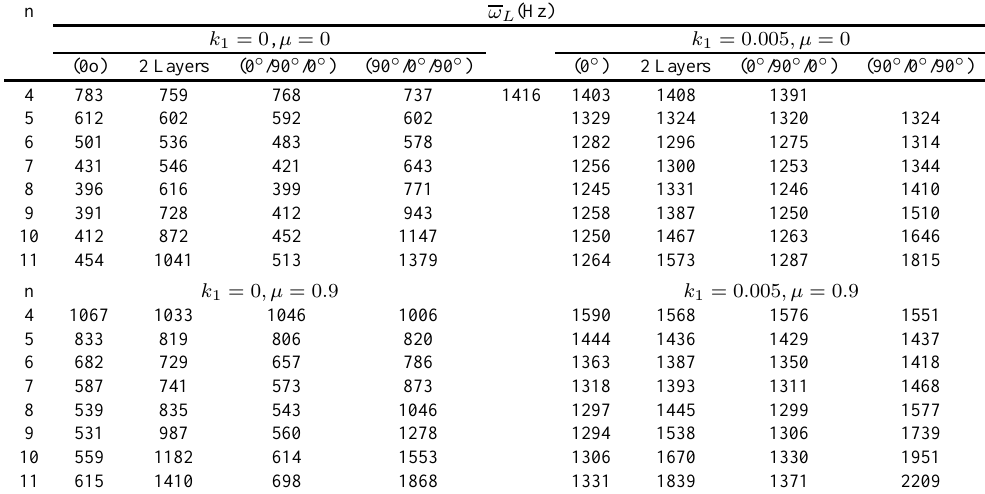
Table 8 Variation of the natural frequency with respect to the number of circumferential waves and number and ordering